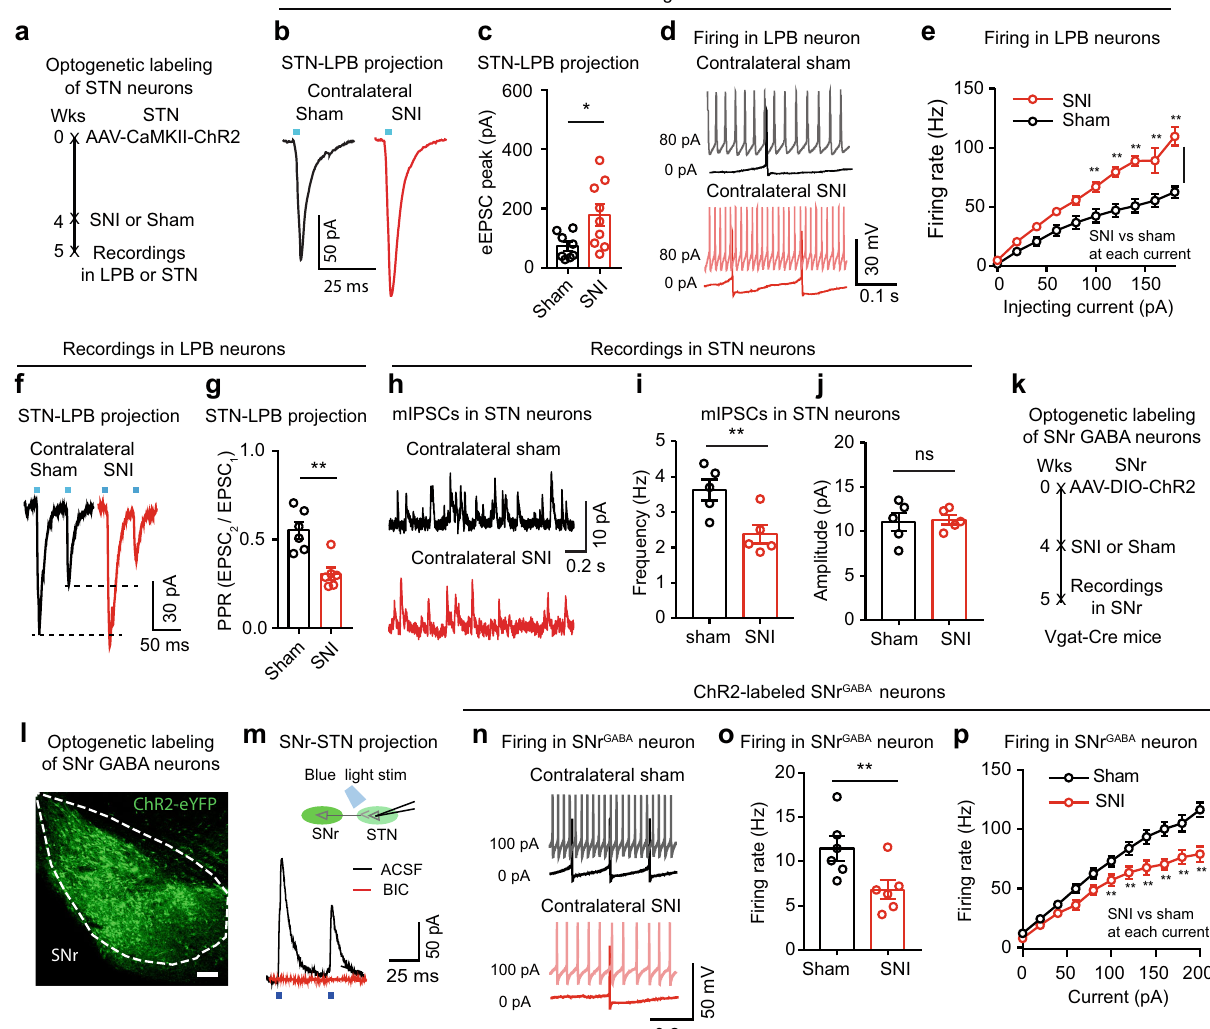
Fig.8|Modi fi cationofSTN Glu – LPB Glu projectioninneuropathicpain.a Timeline of experiments for panels ( b – j ). b , c Example traces ( b ) and peak amplitude ( c ) of blue light (5ms, 2mW)-evoked photo-EPSCs in LPB neurons from sham and SNI mice. c t =2.49, P =0.025, n =9pergroup. d , e Exampletraces( d )andevoked fi ring ( e ) in LPB neurons in week 2 after sham or SNI. Group: F (1, 175) = 100.1, P <0.0001. f – g Example traces ( f ) and paired-pulse ratio (PPR) ( g ) of blue light (5ms, 2mW, 50ms interval)-evoked photo-EPSCs recorded in LPB neurons in slices from sham and SNI mice. g t =4.15, P =0.002, n =6 per group. h – j Example traces ( h ) and quanti fi cation ( i , j )of mIPSCs inSTN neuronsinweek2aftershamorSNI ( n =5per group). Frequency ( i ): t =3.1, P =0.011; Amplitude ( j ): t =0.24, P =0.82. k Timeline